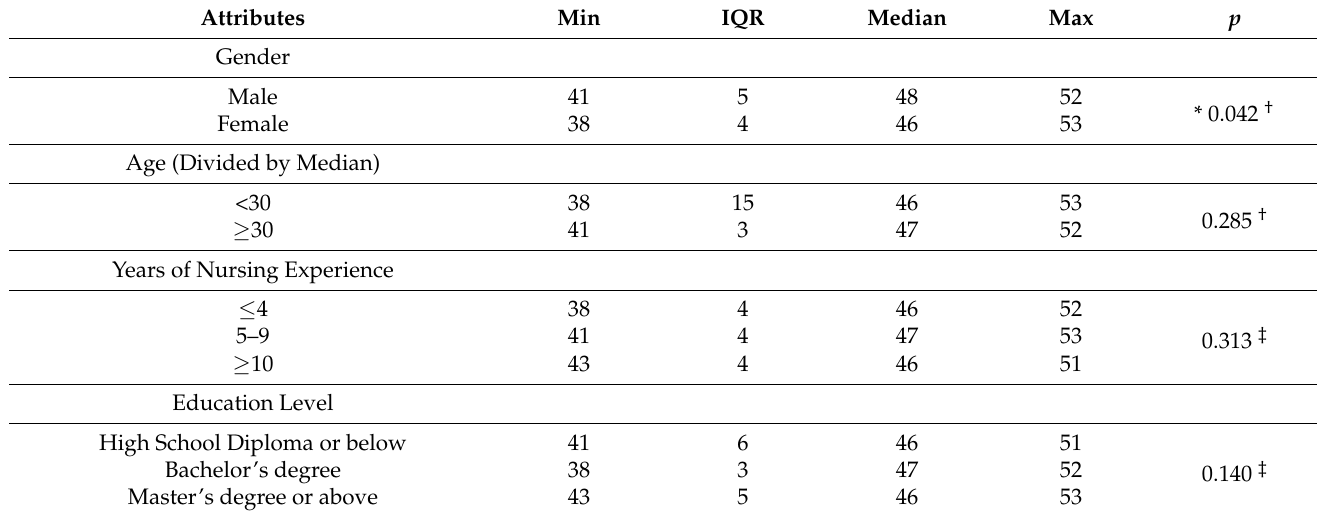
Table 5. Comparison of practice section according to nurses’ demographic